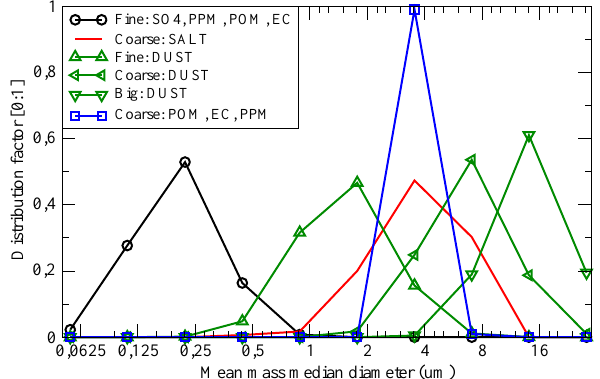
Figure 2. Distribution factors used to project the three aerosols emitted modes on the CHIMERE bins size